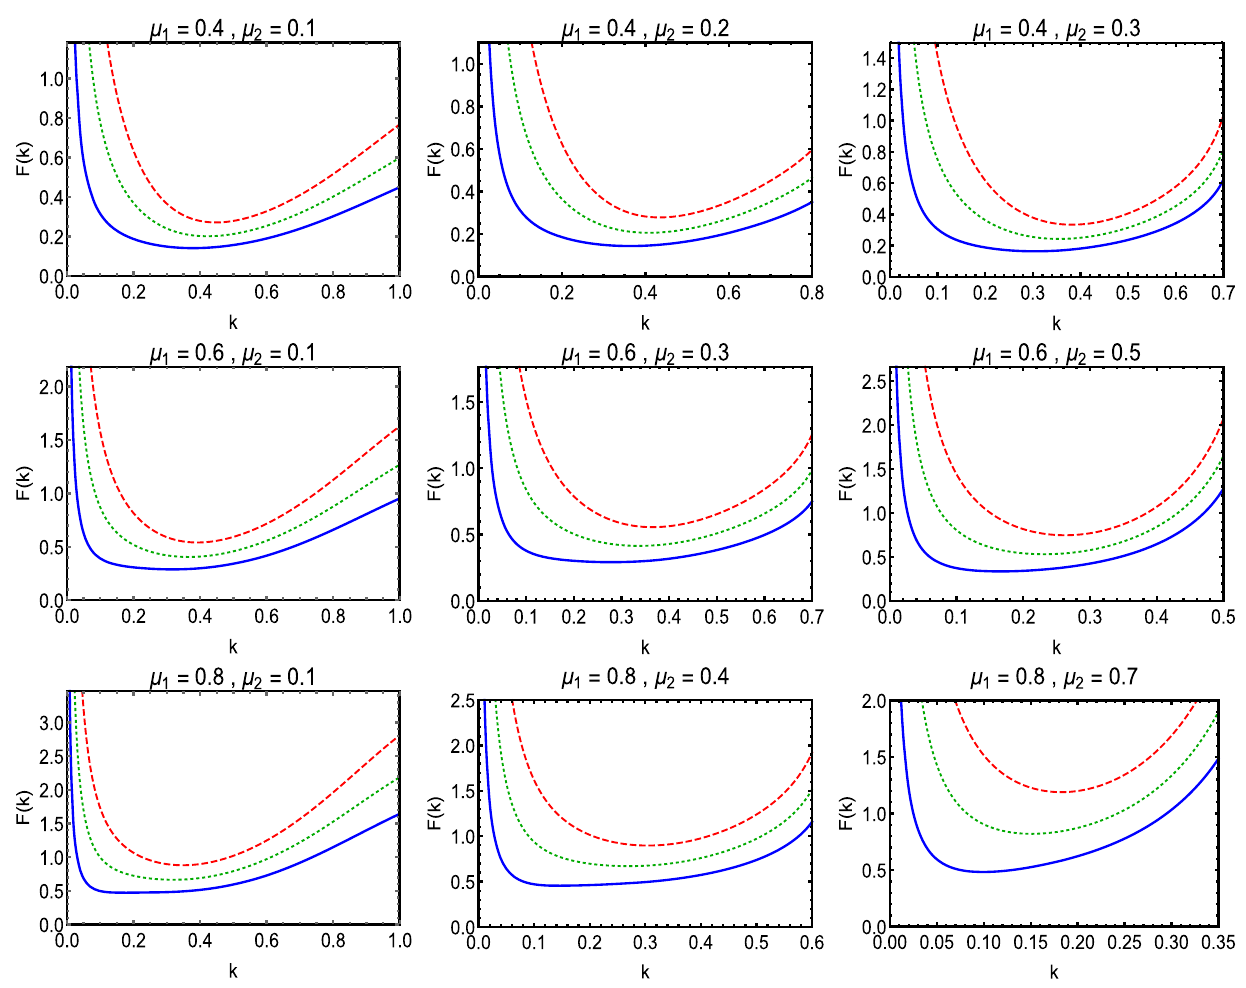
Fig. 1 Profiles of F ( k ) vs k for VEV ratios u 4 / u 2 = 1 . 3 (solid blue), u 4 / u 2 = 1 . 5 (dotted green), and u 4 / u 2 = 1 . 7 (dashed red), and a few representative values of μ 1 and μ 2 for each